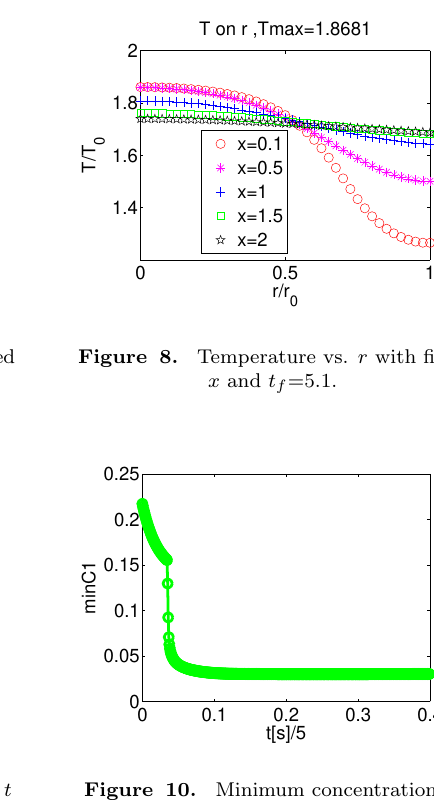
Figure 9. Maximum temperature vs. t at t f =5.1.